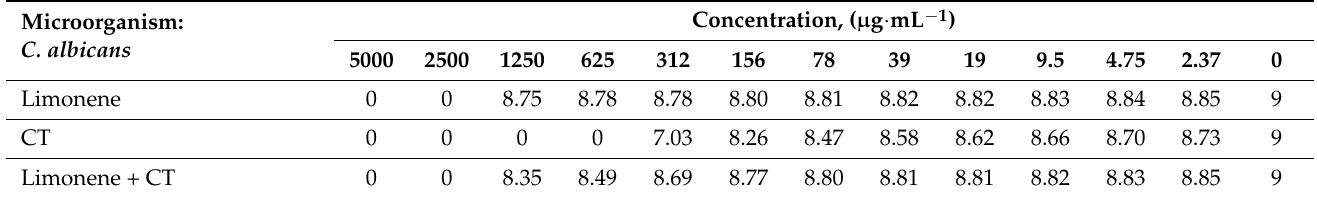
Table 6. Optical densities obtained after 48 h by exposure of C. albicans at different treatments.